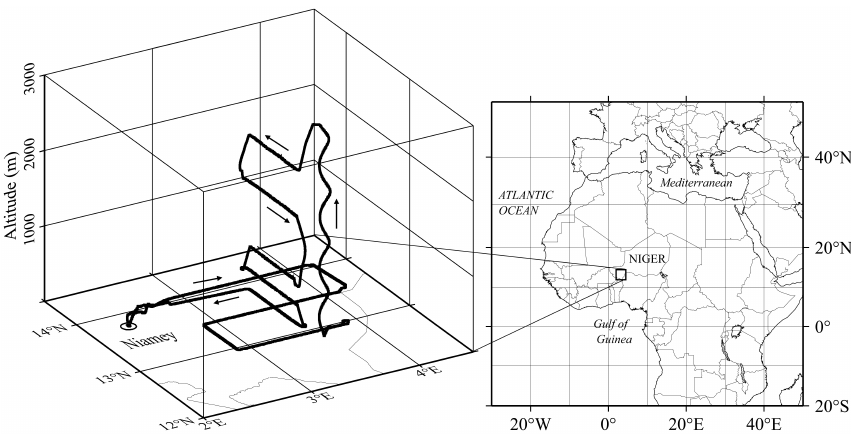
Fig. 2. Geographical location of the measurement area (right panel) and representative flight pattern (left panel) of stacked horizontal legs of the ATR-42 aircraft (from 5 August